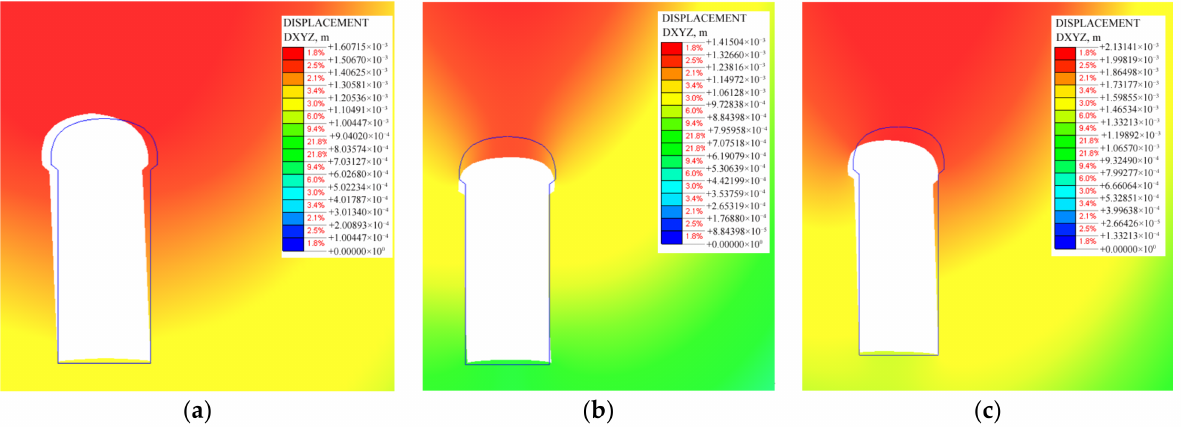
Figure 6. Deformed shapes of the cavern cross − section when the model is loaded by horizontal, i.e., E − W ( a ), vertical ( b ), and both components ( c